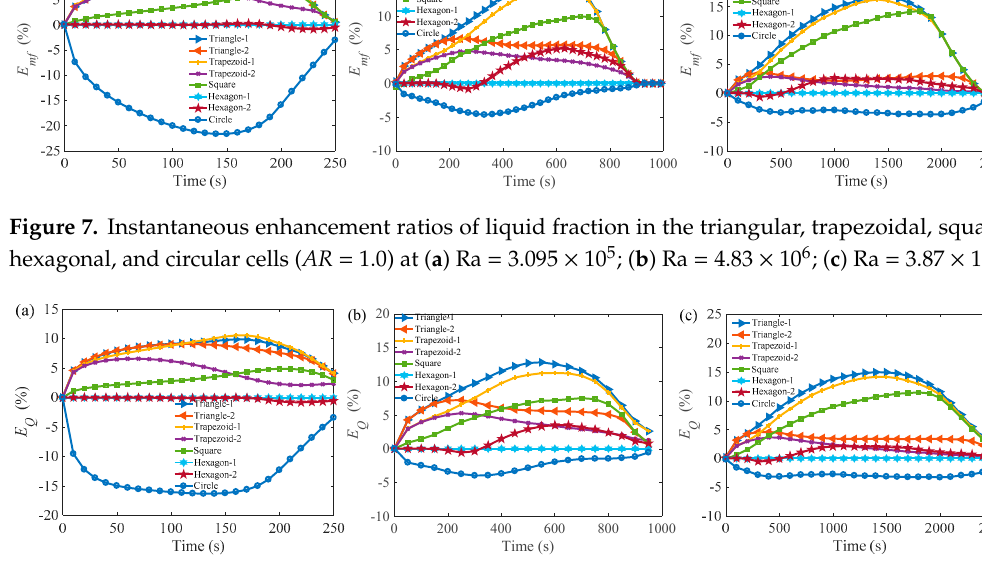
Figure 8. Instantaneous enhancement ratios of energy absorption in the triangular, trapezoidal, square, hexagonal, and circular cells ( AR = 1.0) at ( a ) Ra = 3.095 × 10 5 ; ( b ) Ra = 4.83 × 10 6 ; ( c ) Ra = 3.87 × 10 7 .